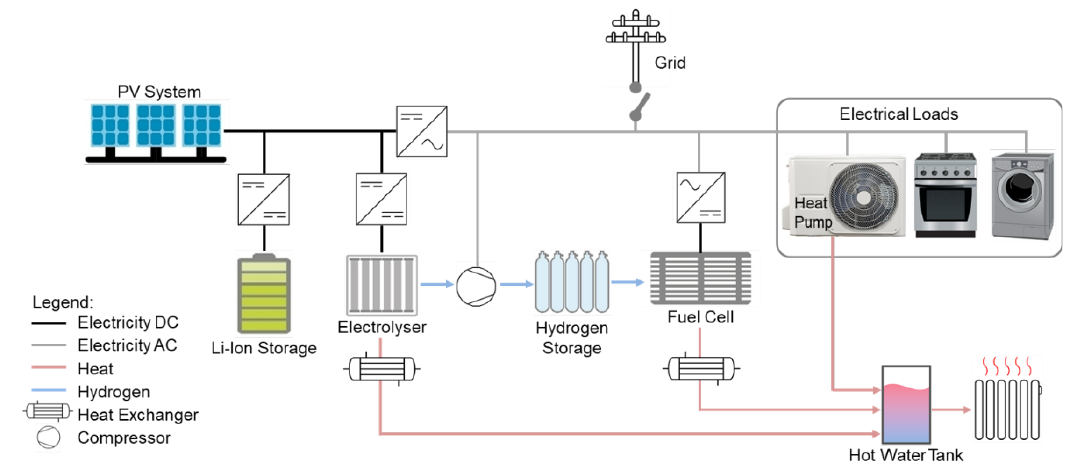
Figure 3. System architecture of the household energy system (image sources: [23]).